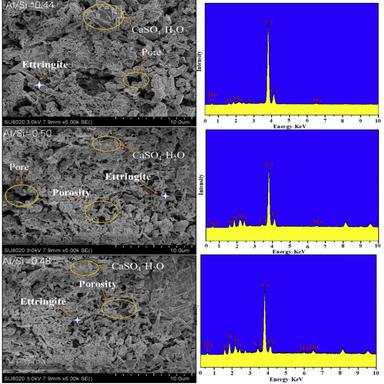
SEM-EDX micrograph of hydrated pastes in different Al/Si ratios.